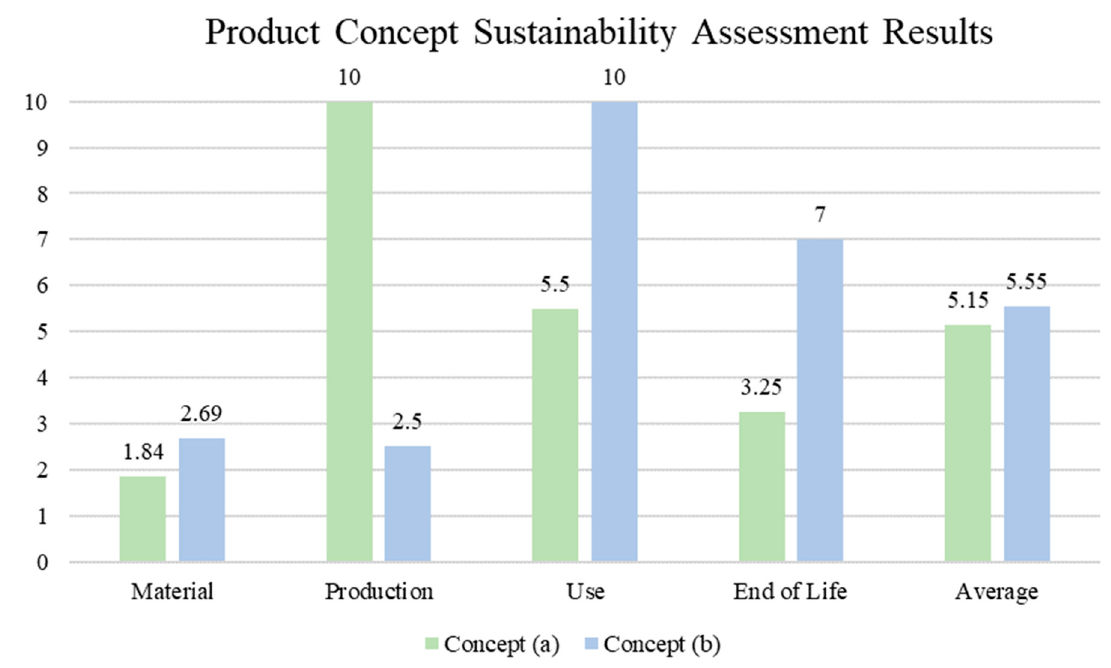
Figure 4. Product concept sustainability assessment results—concepts ( a ) and ( b ).